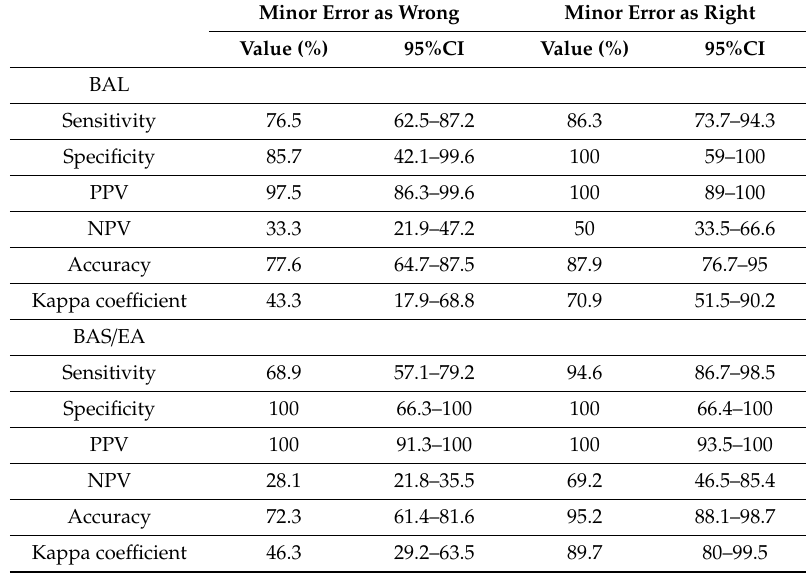
Table 2. Statistics of the use of LAMP to detect pathogens directly from BAL and BAS / EA